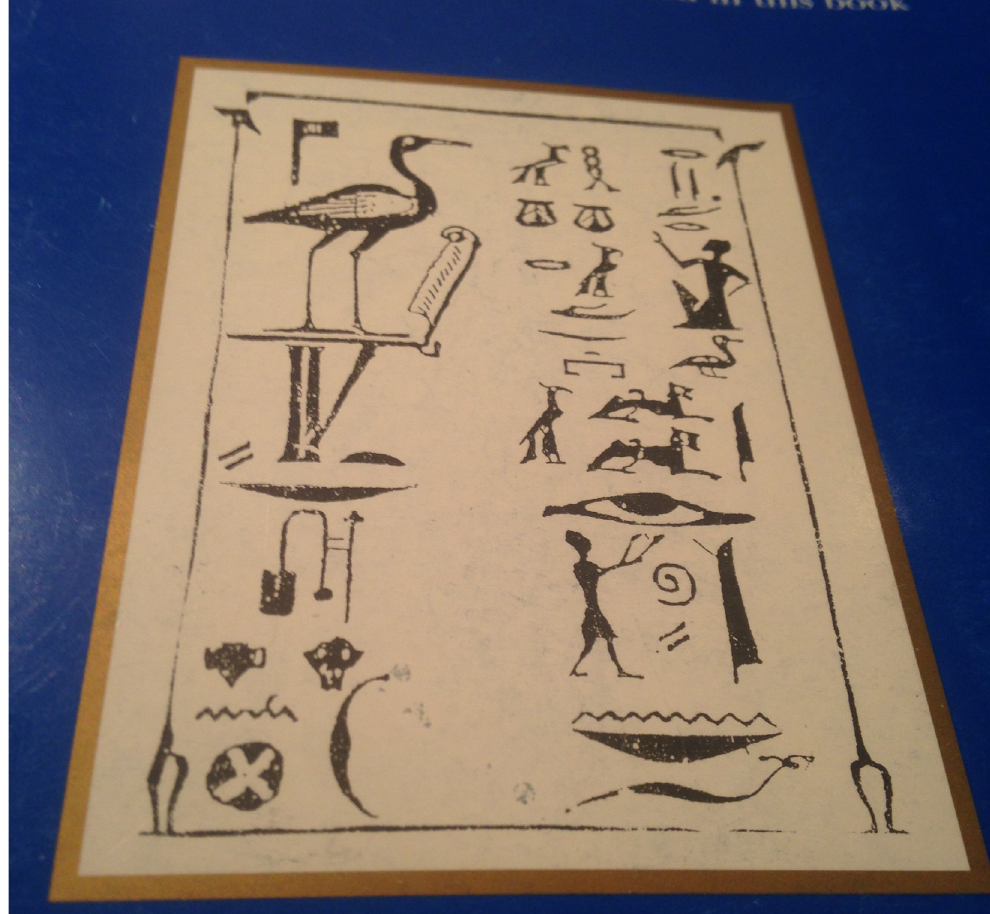
Figure 3. The Hieroglyphic Letterhead and Bookplate of H. Rider Haggard (Author’s photograph after Addy,